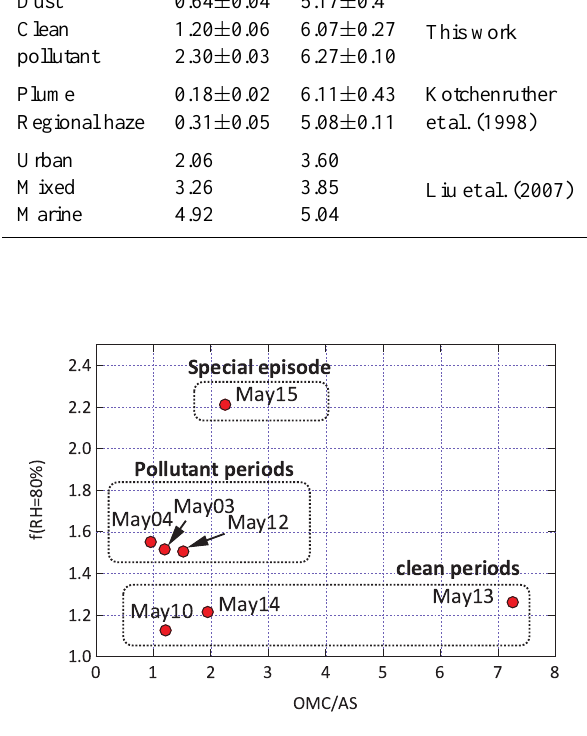
Fig. 6. Relationship between f (RH=80%) and value of OMC/(NH 4 ) 2 SO 4